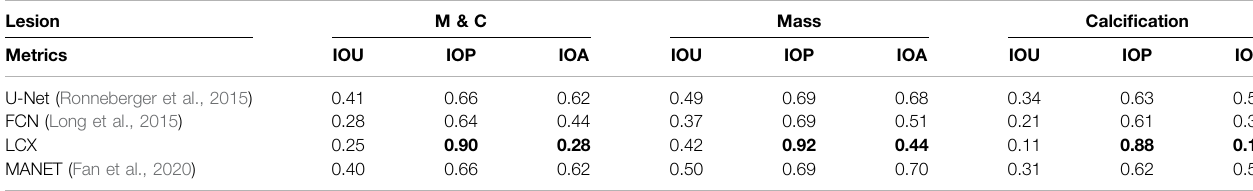
TABLE3| IntersectionPerformance.Meanintersectionoverunion(IOU),prediction(IOP)andannotation(IOA)forLatentCADxandothermodels.Predictedpixelvaluesofall models wasnormalized to0 – 1 range and were threshold at 0.5. Intersection performancewas further examined by binning the values by lesions annotated asMass(M) and Calci fi cation (C). LatentCADx has the maximum mean IOP and minimum mean IOA values. Lesion